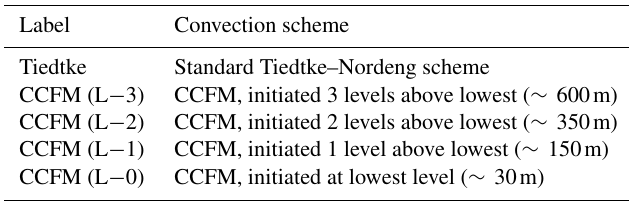
Table 1. ECHAM–HAM configurations.